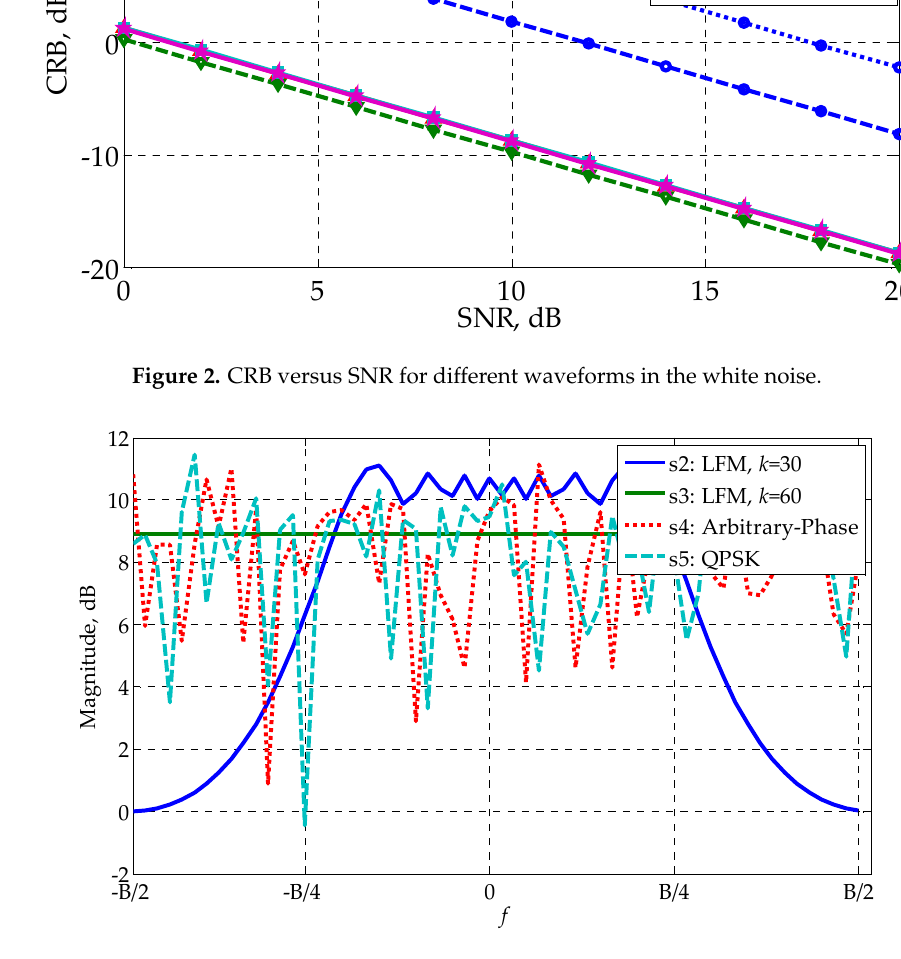
Figure 3. The PSDs of the waveforms s 2 ∼ s